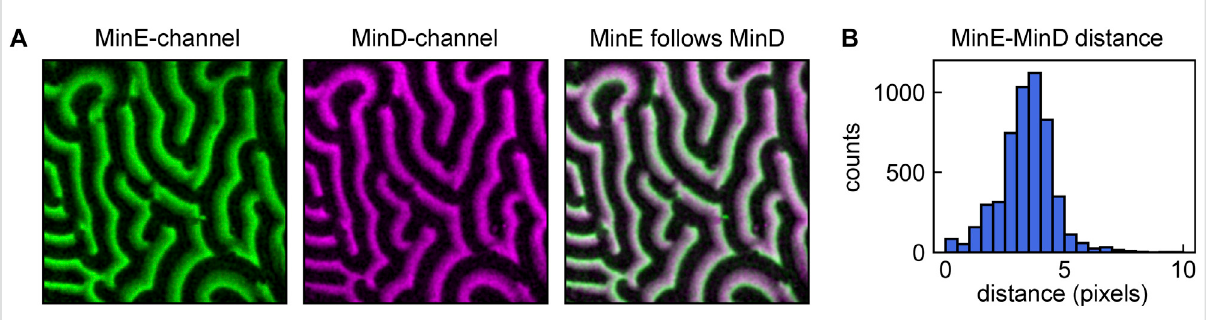
FIGURE 4 UsingthelocalanalysispipelinetodeterminelocalMinE-MinDcrestpositionsshifts. (A) MinD(magenta)andMinE(green)patterns.Thepipeline for local analysis shown in Figures 3A – F can be used to quantify other properties of the pattern, such as the MinE-MinD crest point distance in a simultaneous dual-channel acquisition. Here, crest point detection was performed for each frame of the MinD stack. Subsequently, the intensity traces at these positions were compared to those of the corresponding MinE frame. (B) Distribution of MinE-MinD crest point